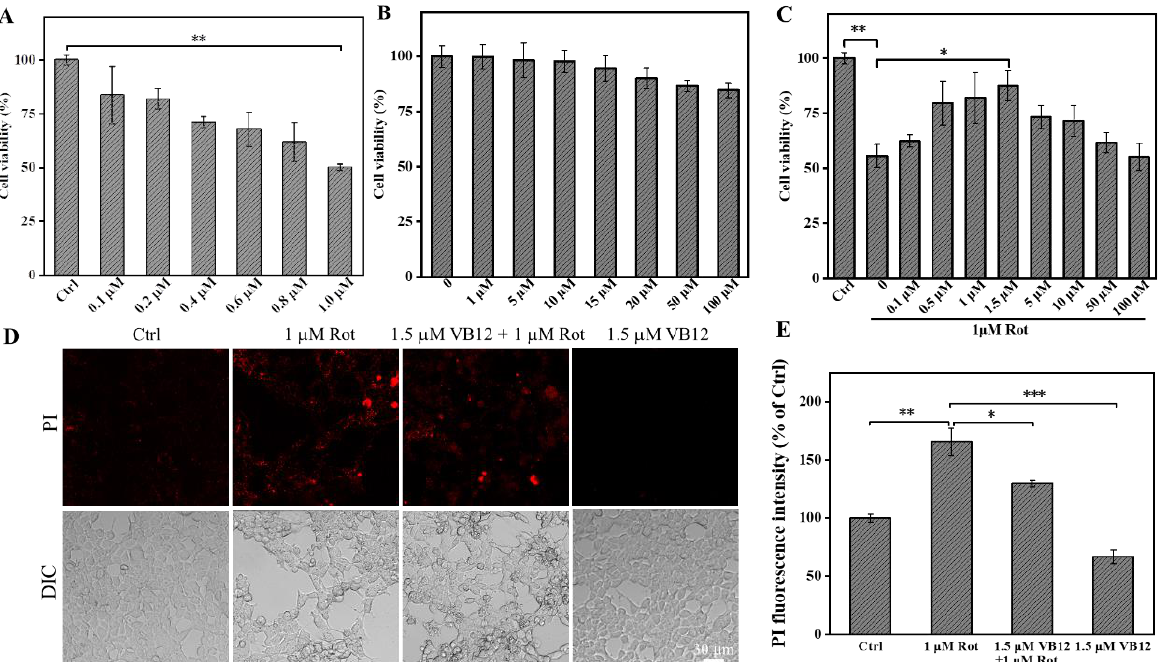
Figure 1. VB12 rescued Rot-induced SH-SY5Y cell death. ( A ) Survival rate of cells under different concentrations of Rot (0.1, 0.2, 0.4, 0.6, 0.8, and 1 μ M). ( B ) The cytotoxicity of VB12 at different con- centrations. ( C ) Cell viability of SH-SY5Y cells pretreated with VB12 when exposed to Rot. ( D ) SH- SY5Y cells were pretreated with VB12 at the specified concentration for 3 h and exposed to Rot (1 μM) for an additional 24 h. (E) Quantization of PI fluorescence. Scale bar = 30 μm. Data are the mean ± SEM, n = 3. * p < 0.05, ** p < 0.01, *** p < 0.001 compared with other groups.